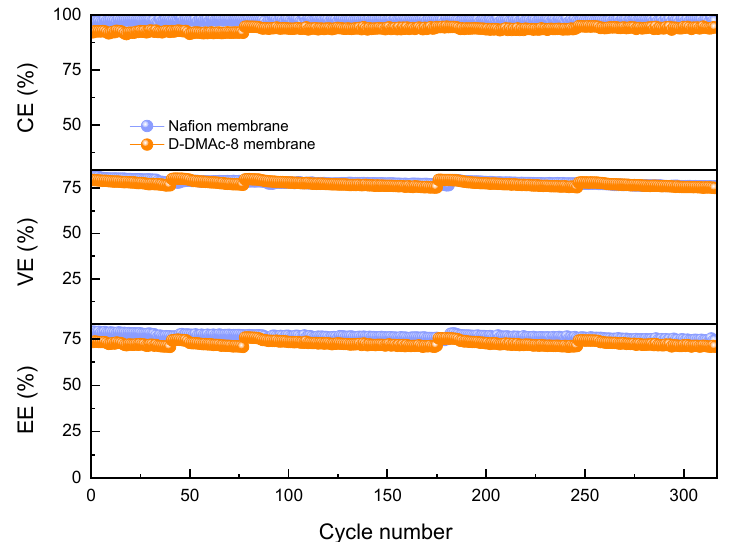
Figure 8. Cycling performance of ICFB assembled with the D-DMAc-8 and Nafion membranes at the current density of 80 mA cm − 2 .